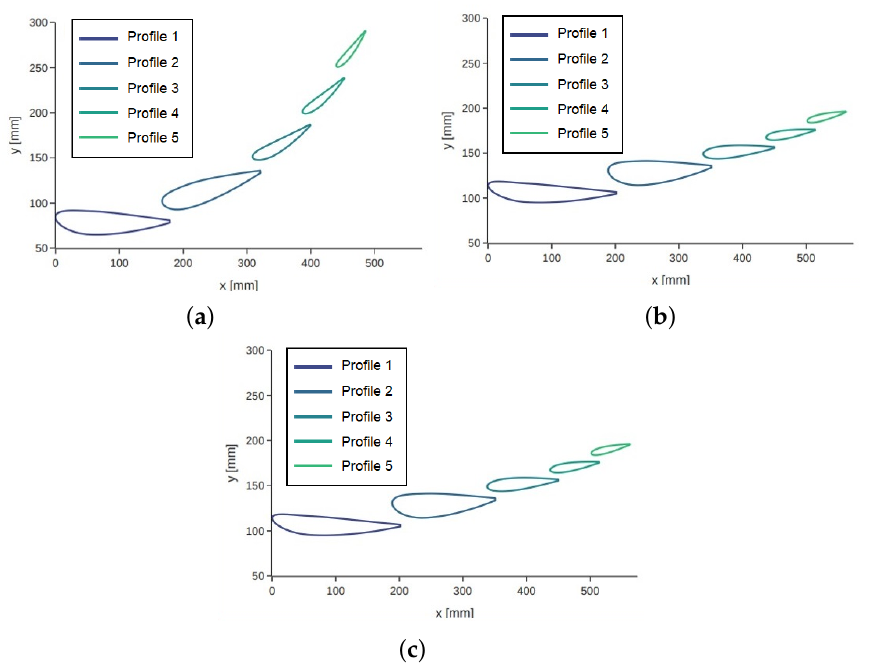
Figure 8. Optimal parametric designs for ( a ) A-A cross-section (400 mm), ( b ) B-B cross-section (670 mm), and ( c ) C-C cross-section (940